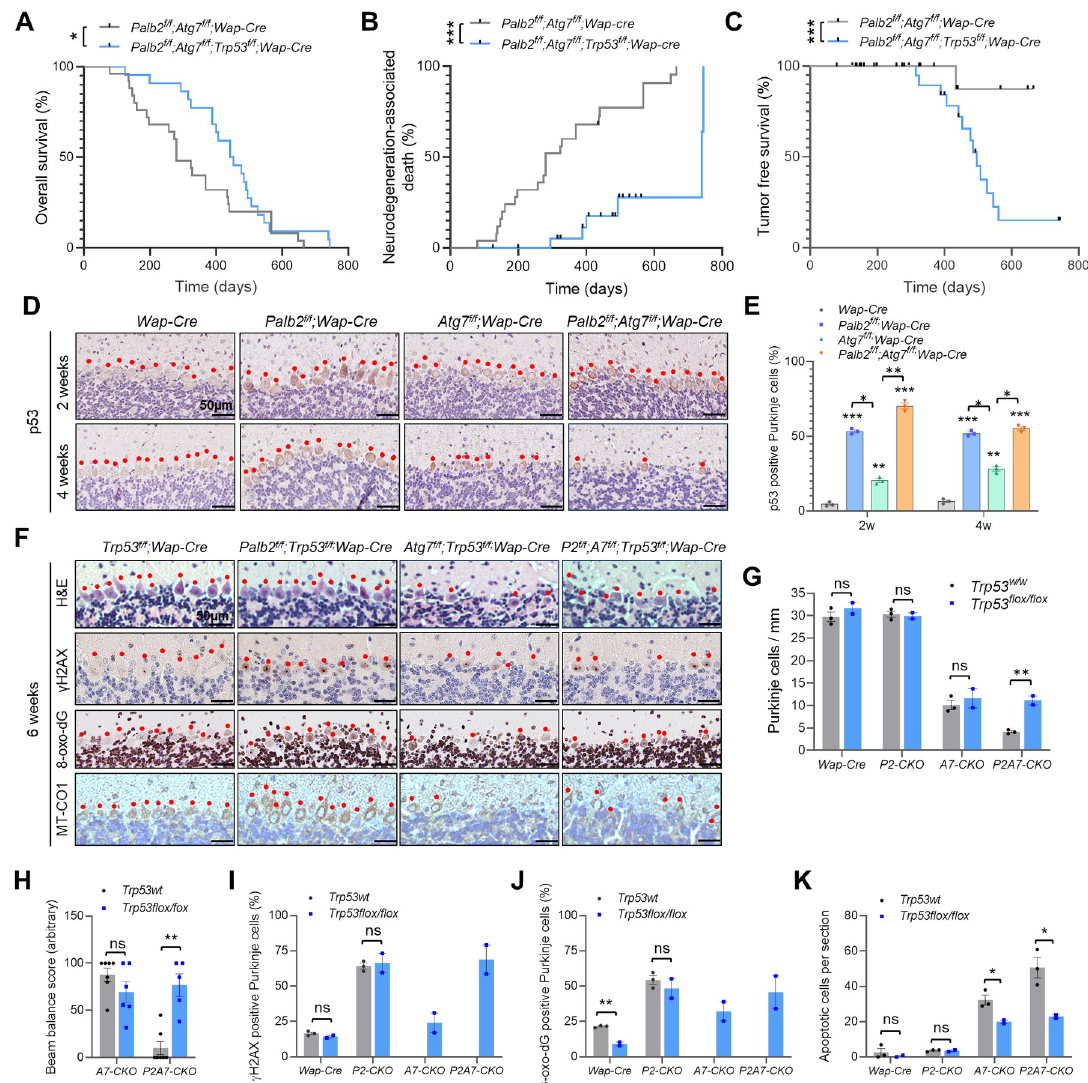
Fig 7. Role of p53 in Purkinje cell death and the survival of Palb2;Atg7 -CKO mice. (A-C) Overall survival (A), neurodegeneration- associated death (B), and tumor free survival (C) of Palb2;Atg7 -CKO and Palb2;Atg7;Trp53 -CKO mice. Where applicable, black ticks indicate censoring events. Palb2;Atg7 -CKO, n = 25; Palb2;Atg7;Trp53 -CKO, n = 22. (D and E) Representative p53 IHC images (D) and quantification of p53 positive Purkinje cells (E) in the cerebellum of control and CKO mice at 2 and 4 weeks of age. Red dots indicate Purkinje cells. Scale bar = 50 μ m. n = 3 mice per genotype per time point. (F) Representative H&E and IHC images of γ H2AX, 8-oxo- dG and MT-CO1 in the cerebellum of the CKO mice at 6 weeks of age. Images are representatives from two independent experiments. Red dots indicate Purkinje cells. Scale bar = 50 μ m. (G) Purkinje cell numbers in the CKO mice at 6 weeks of age, n = 2–3 mice per genotype. (H) Beam balance scores of the CKO mice at 11 weeks of age. n = 5–7 mice per genotype. (I and J) Quantification of γ H2AX positive (I) and 8-oxo-dG positive (J) Purkinje cells at 6 weeks of age. n = 2–3 mice per genotype. (K) Number of apoptotic cells in the cerebellum of 6 weeks old control and CKO mice. n = 2–3 mice per genotype.